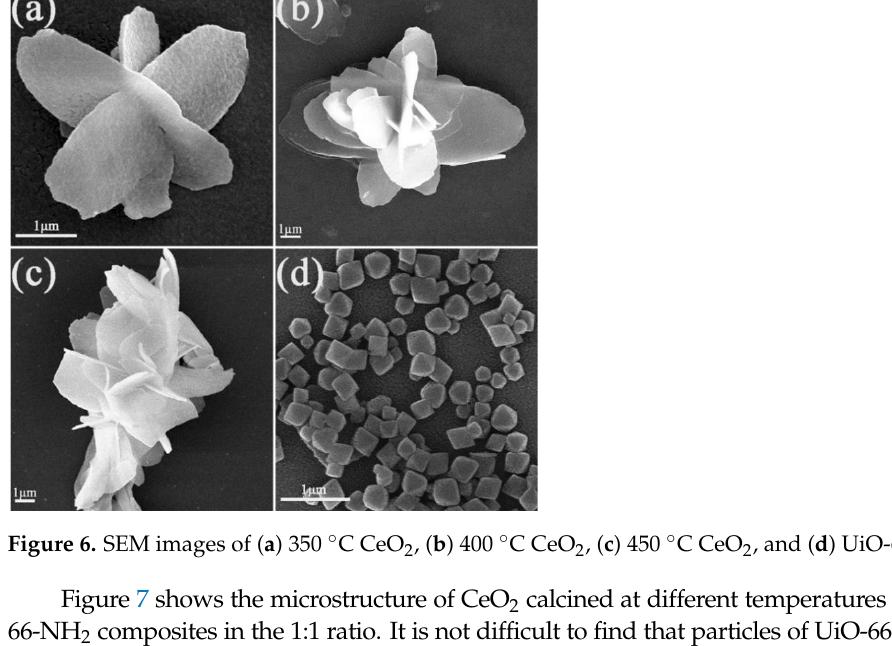
Figure 6. SEM images of ( a ) 350 °C CeO 2 , ( b ) 400 °C CeO 2 , ( c ) 450 °C CeO 2 , and ( d ) UiO-66-NH 2 .